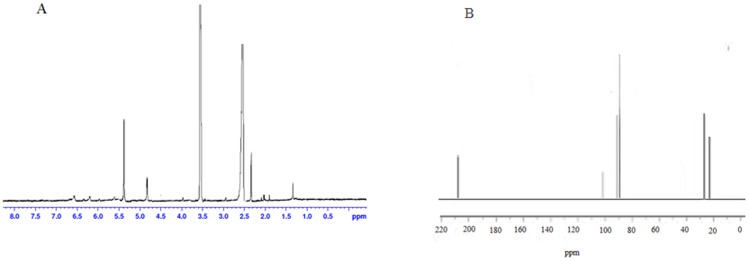
H NMR (A) and 13 C NMR (B) spectrum of methylglyoxal.The NMR data present a mixture of mono- and dihydrate forms of methylglyoxal.